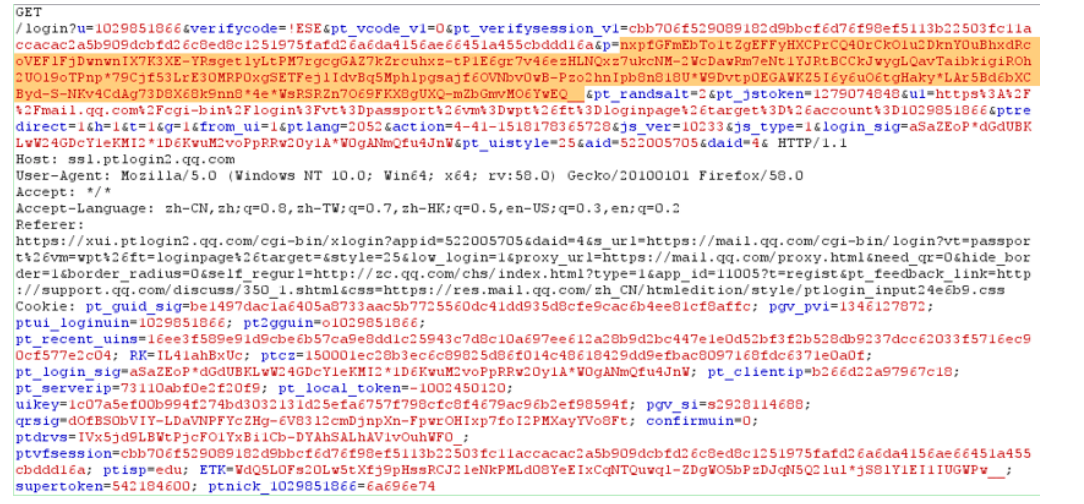
Figure 28. The constructed request message.